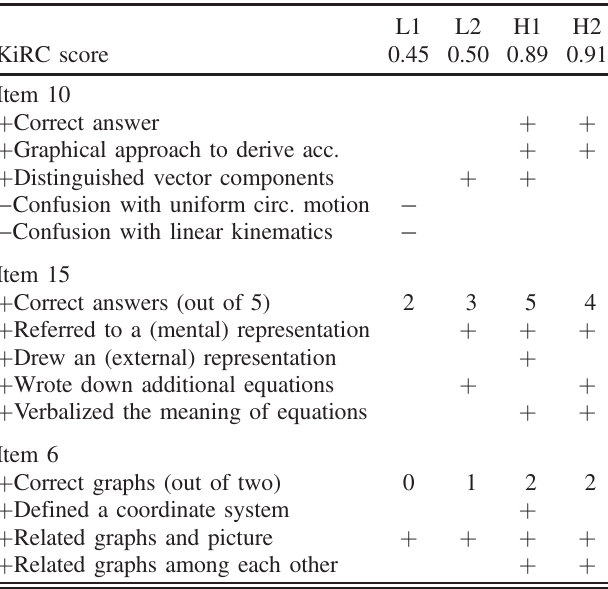
TABLE II. Representational competence indicators related to three KiRC items and if they appeared among the four inter- viewees. Positive indicators are denoted with a plus ( þ ), whereas indicators opposed to expertlike representation use are denoted with a minus ( −